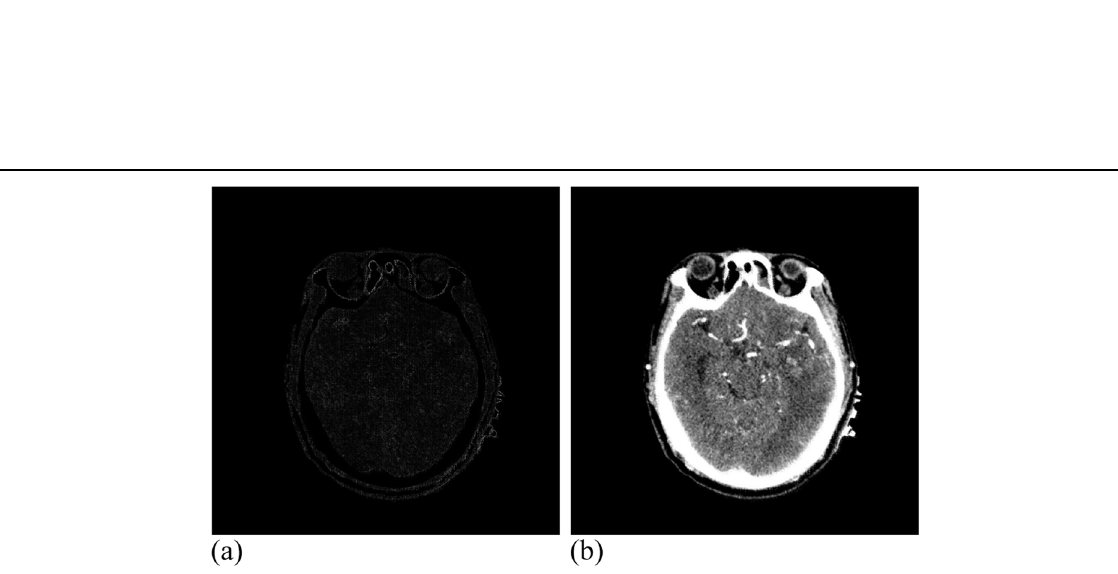
Fig. 19 CT data after registration. (a) : Difference between CT reference image and registration image; ( b ): CT registration image